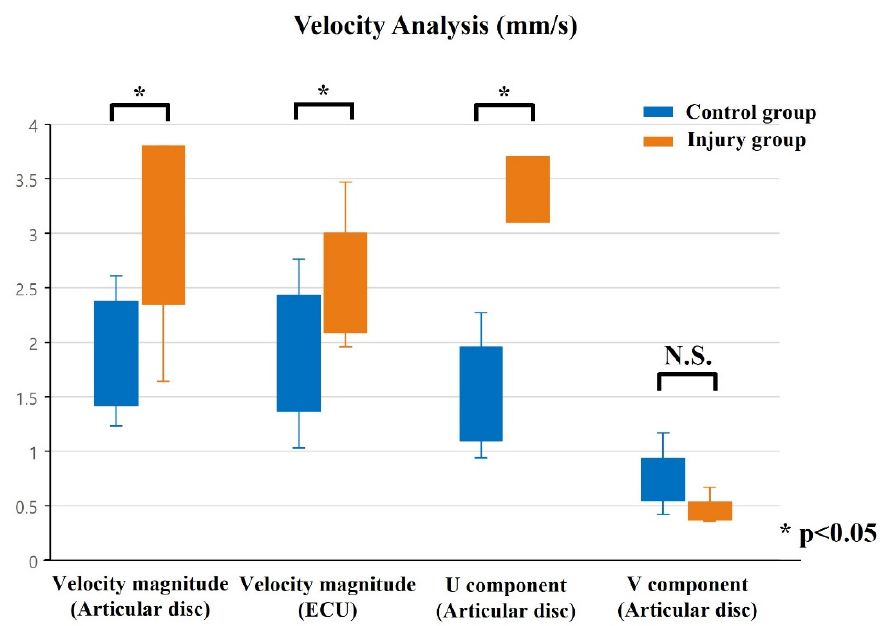
Figure 8. Results from PIV analysis. In the injury group, the velocity magnitude of the articular disc and the ECU tendon was significantly higher than that in the control group. The u-component of the articular disc was also significantly